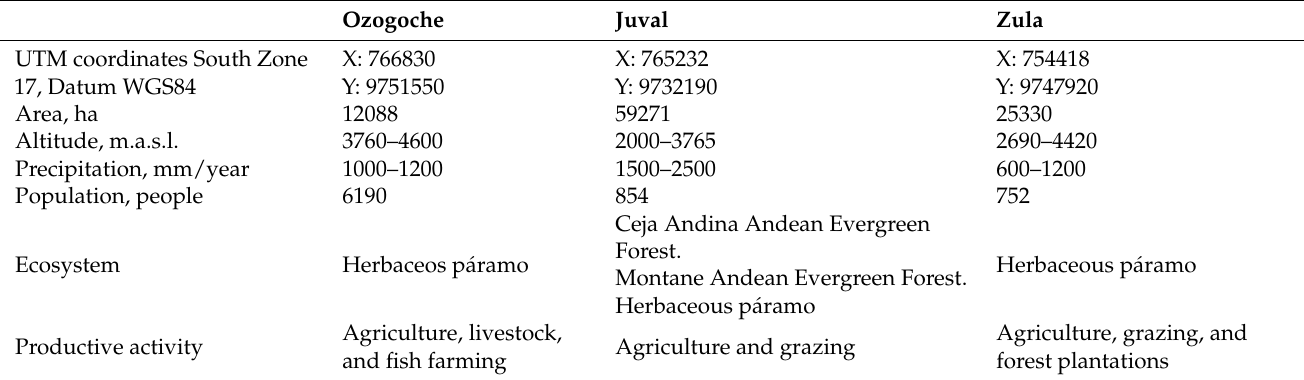
Table 1. Attributes of interest in the three studied